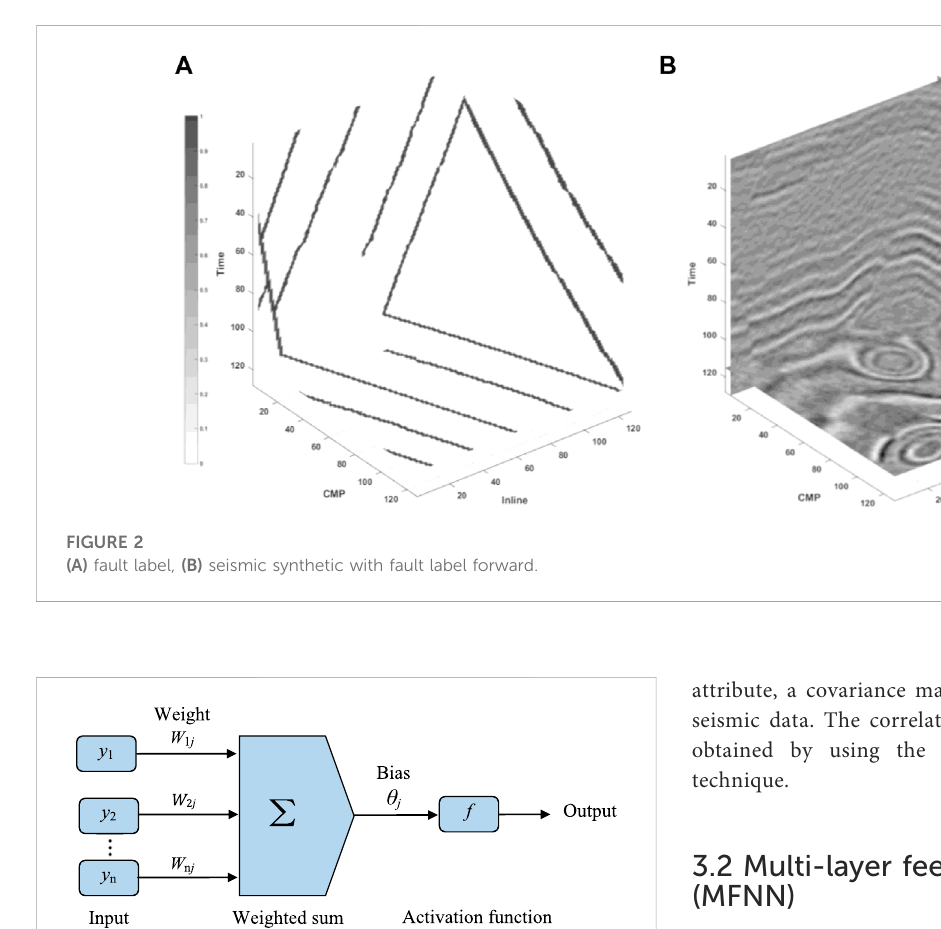
FIGURE 3 Schematic diagram of forward propagation